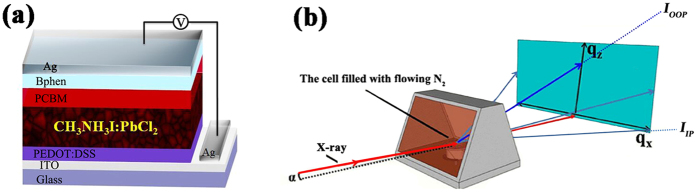
(a) Schematic of the perovskite solar cells with a structure of ITO/PEDOT:PSS/CH3NH3PbI3−xClx/PC70BM/Bphen/Ag. (b) The GIXRD experimental setup, where a, IOOP, IIP, is the beam incident angle, the intensity of scattering beam along the out-of-plane (OOP) and in-pane (IP) directions, respectively. The samples are in a sealed cell with flowing nitrogen (N2).